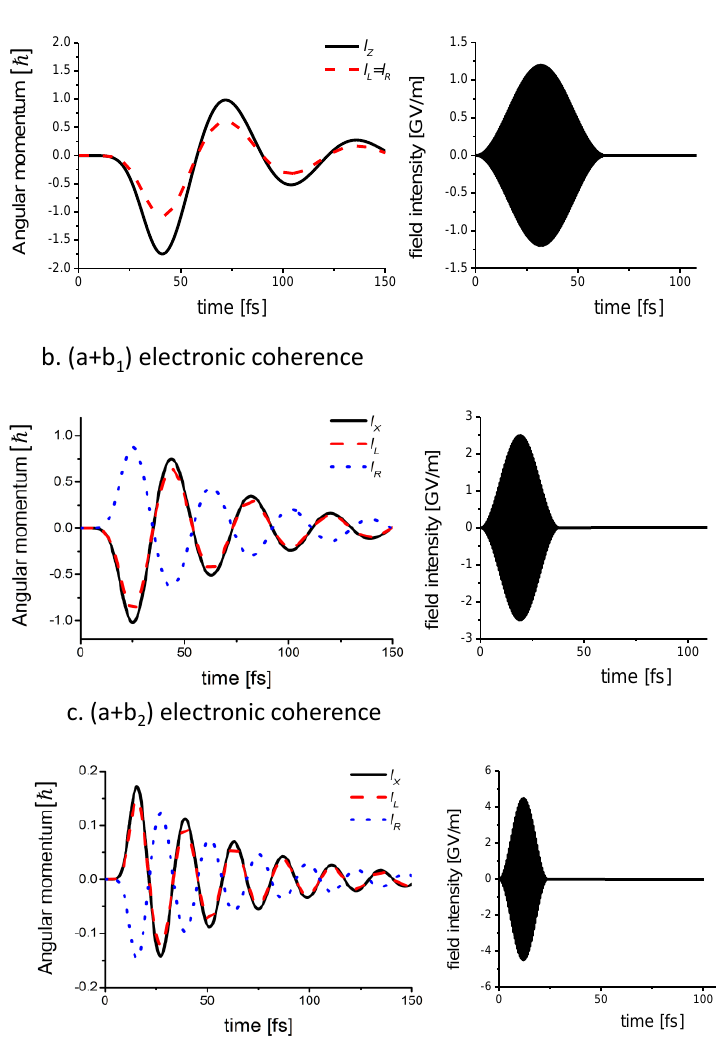
Figure 10. Time-dependent coherent angular momentum of ( P )-2,2′-biphenol for three types of electronic coherence. Modified from [87] with permission of the American Institute of Physics. The pulse form for (a + b 2 ) electronic coherence in [87] should be replaced by that in the figure.